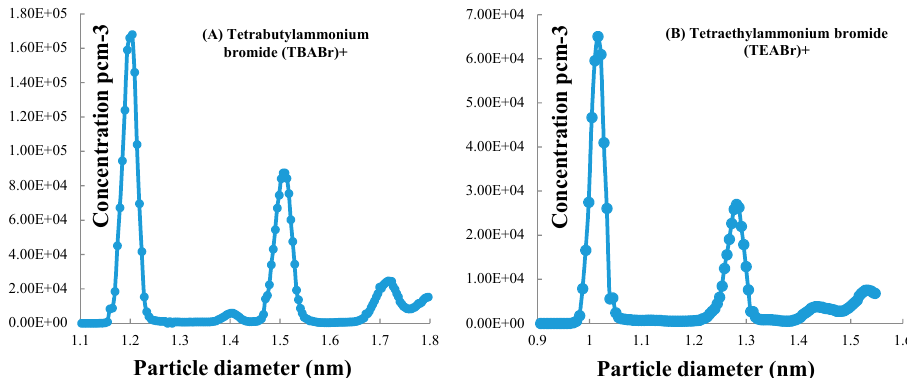
Particle diameter (nm) Figure 2. Mobility size distribution of positively electrosprayed cluster ions the tetraheptylammonium bromide (TEABr) and tetrabutylammonium bromide (TBABr) with an aerosol electrometer.